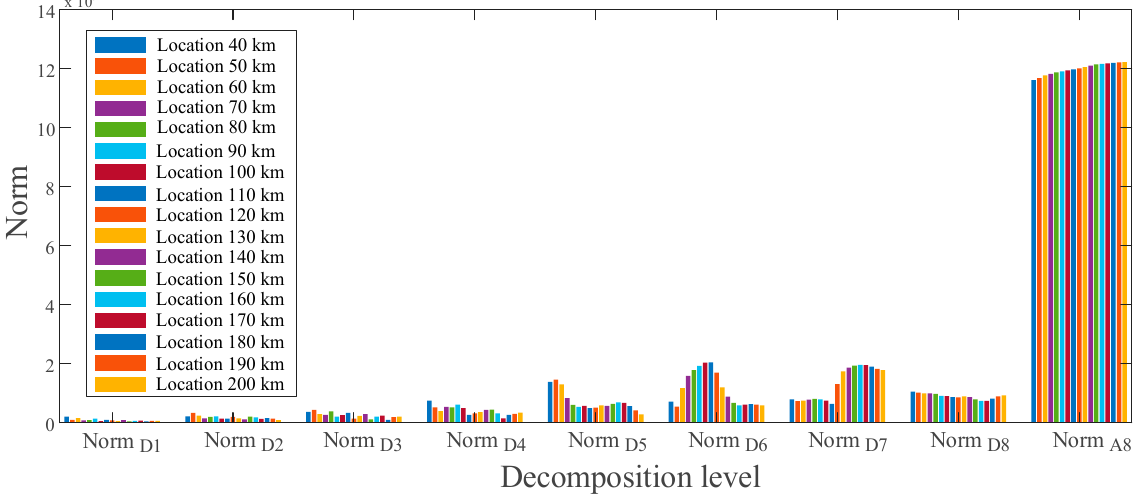
Figure 10. Feature vector extracted for the PTP fault at various locations of the voltage signal.